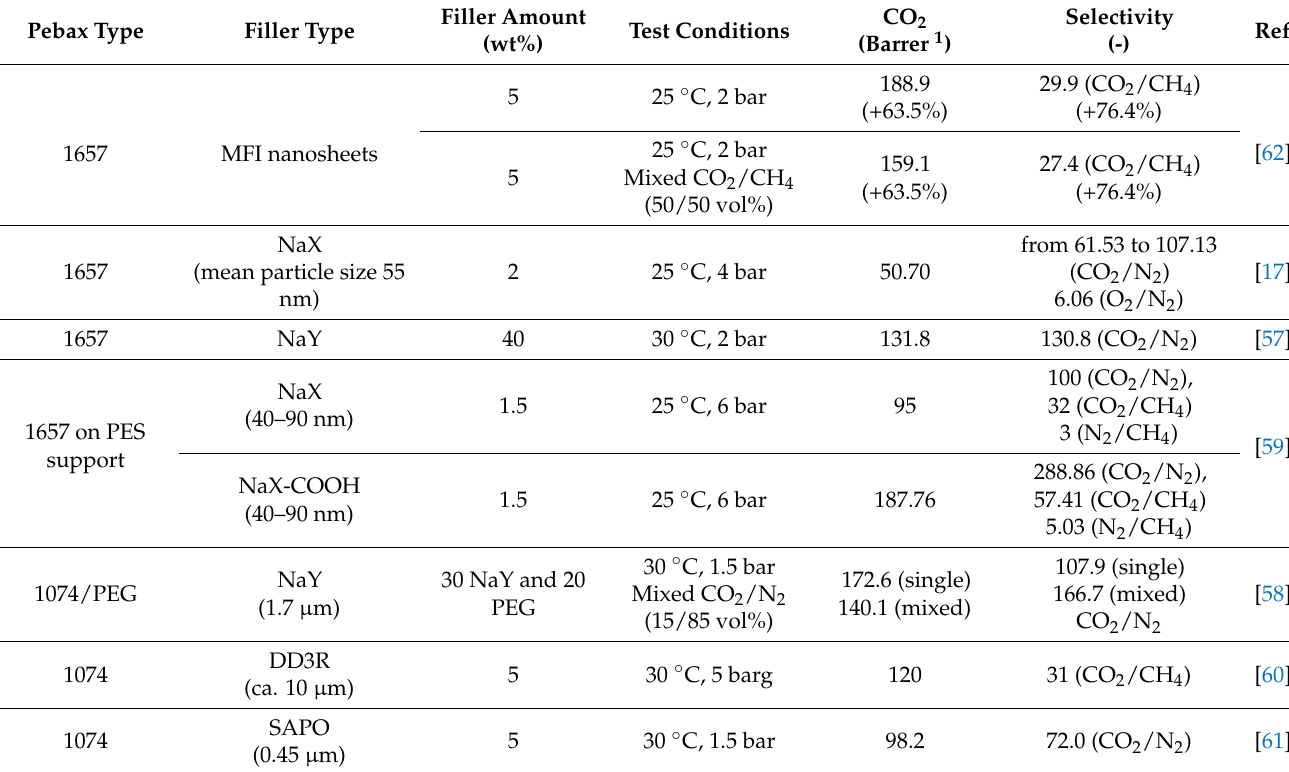
Table 6. Permeation properties of selected Pebax-based MMMs filled with